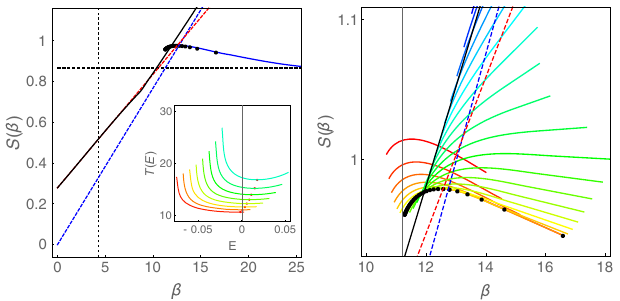
FIG. 3. Tunneling action as a function of inverse temperature β , 0 , q 0 . 533 at s ¼ 0 . 85 > s for q . Left: Black dots QPT min ¼ max ¼ and the solid blue line fit correspond to an optimal finite- temperature quantum-tunneling action. The horizontal dotted line is the β → ∞ limit of the incoherent tunneling action corresponding to the quantum-mechanical tunneling from the lowest level of the metastable well corresponding to k ¼ 0 . The solid black line corresponds to the optimal action of the classical Glauber dynamics. Blue and red dashed lines show the classical over-the-barrier escape action at k ¼ 0 and along the line q ¼ 1 − 2 k with the potential maximum at k ≈ 0 . 152 , respectively. (cid:4) The latter, k , is the point of inflection, i.e., the point where the (cid:4) minimum of the right potential well merges with the maximum at the barrier top (see Fig. 2). The vertical dashed line corresponds to the temperature-driven phase transition point β PT ≈ 4 . 32 corresponding to equal occupation of the two potential wells. Inset: T ð E Þ ¼ −∂ S= ∂ E at fixed k , which corresponds to the period of quantum-mechanical tunneling trajectory in the imagi- nary time representation. The dominant contribution comes from tunneling at the energy determined from T ð E Þ ¼ β for β > T ; min at β < T , the transition rate is dominated by the over-the- min barrier escape. Different lines from bottom to top correspond to different values of s at fixed k ¼ 0 . Red dots correspond to T . min T Note that the minimum E : T ð E does not corre- min min Þ ¼ min spond to the highest tunneling energy. This means that the transition from the quantum-tunneling regime to over-the-barrier escape has discontinuous first-order character. Right: Quantum- classical transition region on a larger scale. Black dots correspond to the dominant tunneling action at each β . Different lines show the quantum-mechanical tunneling action for fixed k ; colors correspond to growing 0 ≤ k ≤ 0 . 152 (red to blue). The quantum- tunneling process conserves energy and the total spin value k . E k At k > k , the point where E L ð k , the quantum R ð LR LR Þ ¼ LR Þ mechanical tunneling process requires the state in the metastable well to be at an energy E ≥ E R ð k Þ , which comes with an additional thermal excitation cost β ½ E R ð k Þ − E L ð k Þ(cid:2) in the tun- neling action. Therefore, for growing k , the tunneling action S ð β Þ resembles linear classical dependence. Solid black and dashed red and blue lines are the same as in the left